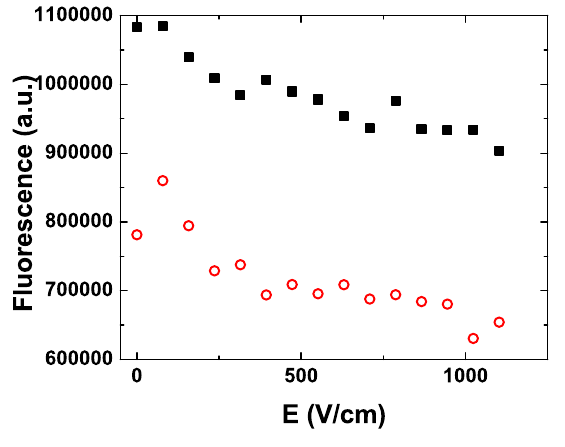
Figure 2. The relative number of atoms in the MOT vs. the electric field